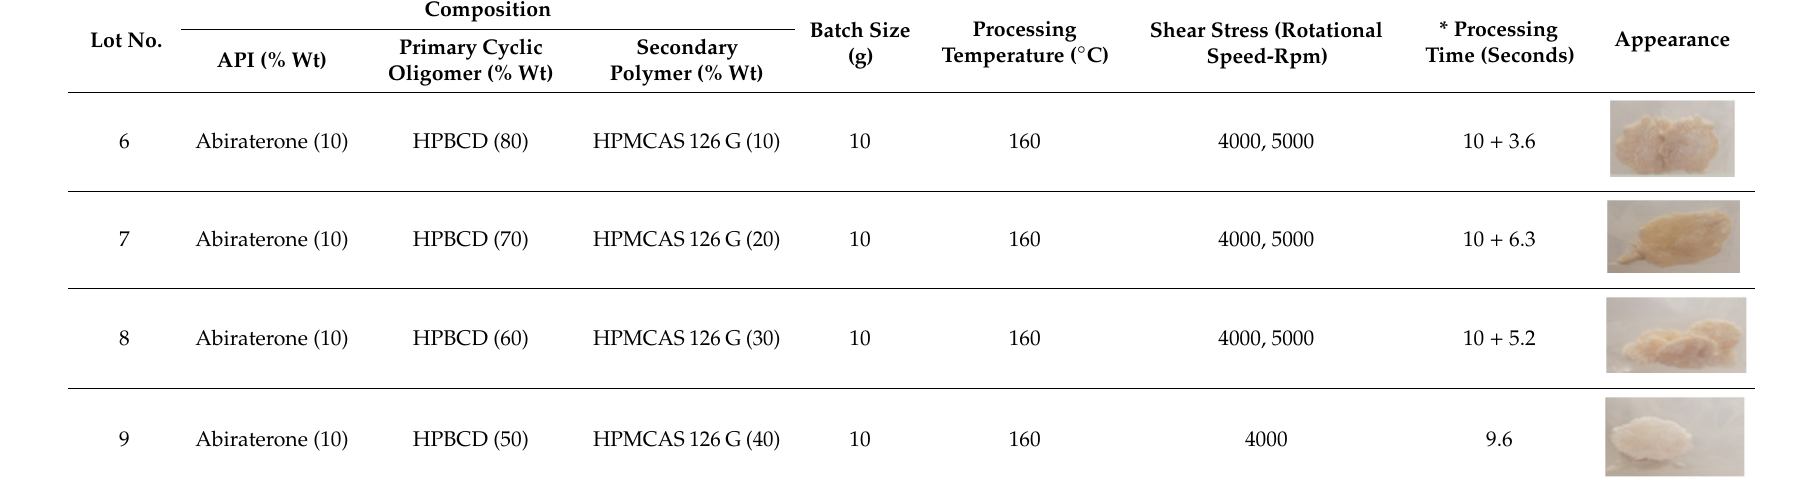
Table 4. Ternary KSD composition, processing parameters, and appearance.